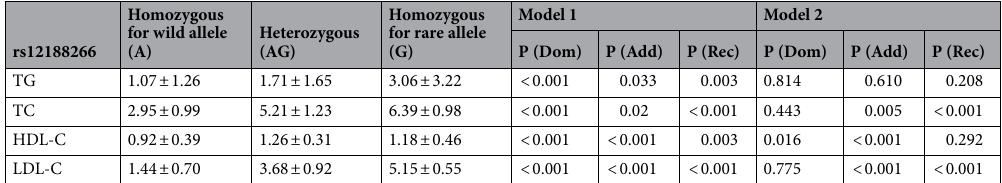
Table 4. Associations between rs12188266 and lipid parameters. TC total cholesterol; LDL-C low density lipoprotein-cholesterol; HDL-C high density lipoprotein-cholesterol; TG triglycerides; Dom dominant model; Rec recessive model; Add additive model; Model 1 unadjusted model; Model 2 analysis of covariance adjusted for sex, age, smoking, obesity, drinking, diabetes, hypertension and lipid profiles.